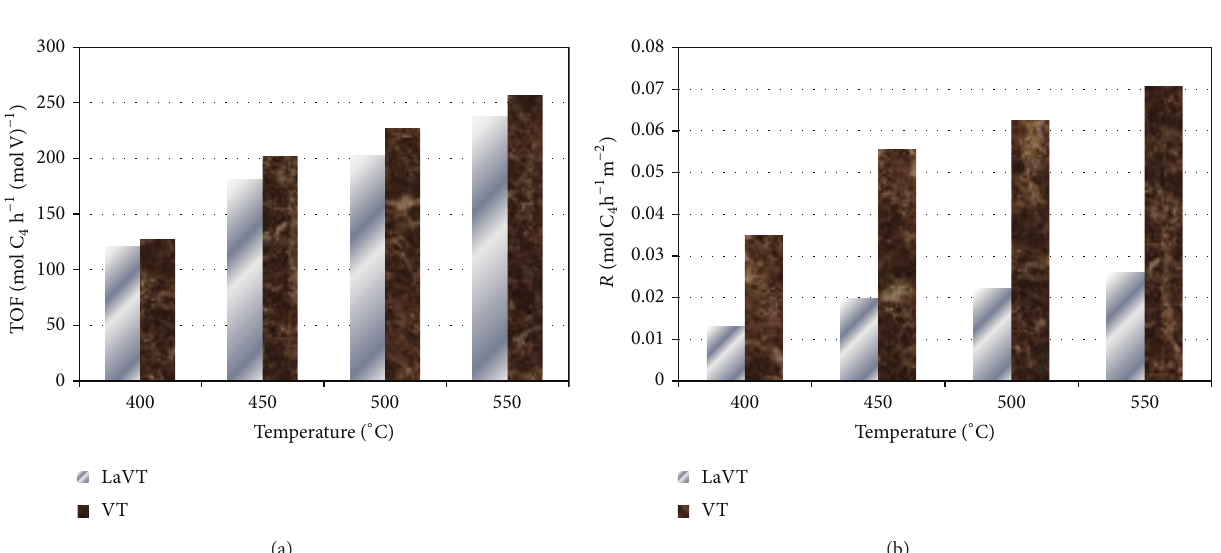
Figure 7: Variation of turnover (in molC 4 h −1 (molV) −1 ) and the specific rate (in molC 4 h −1 m −2 ) with undoped and La-doped VO 𝑥 / TiO 2